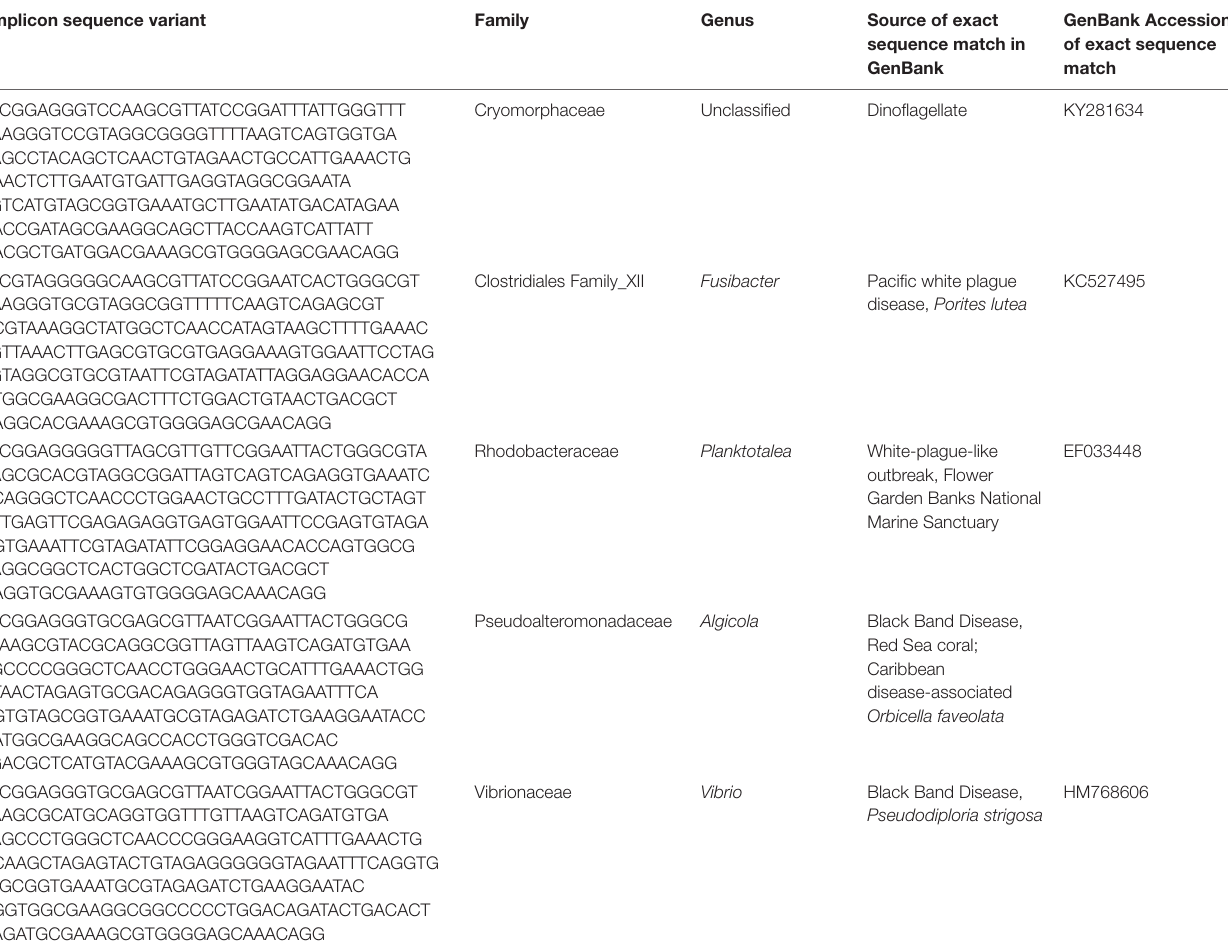
TABLE 1 | Amplicon sequence variants detected as differentially abundant in stony coral tissue loss disease lesions compared to apparently healthy tissue on diseased corals in Montastraea cavernosa , Diploria labyrinthiformis , and Dichocoenia stokesii